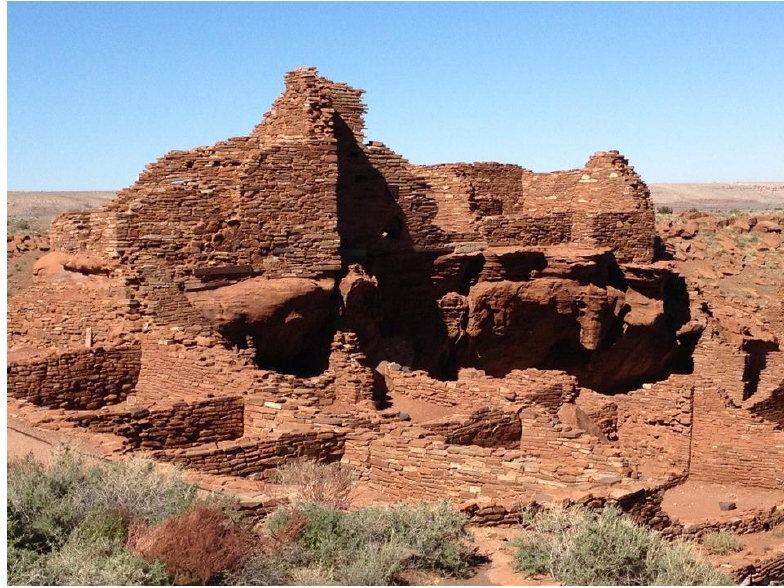
Figure 7. Wupatki Pueblo built on and around massive rocks [35].